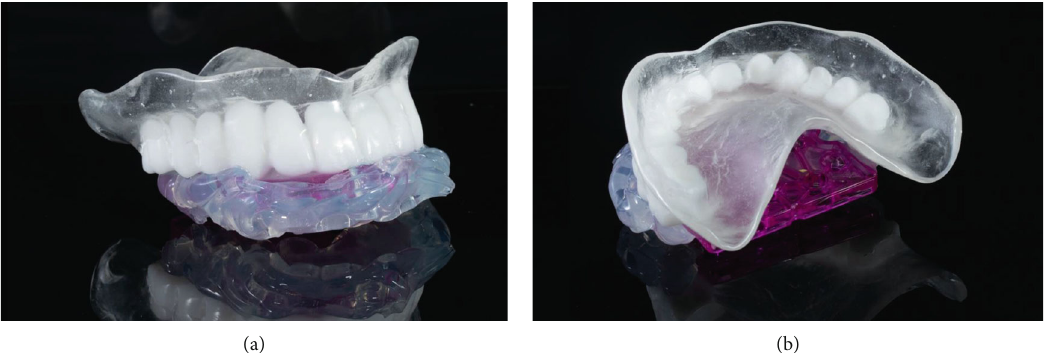
Figure 3: (a) Frontal view of the radiographic template. (b) View on the base area of the radiographic